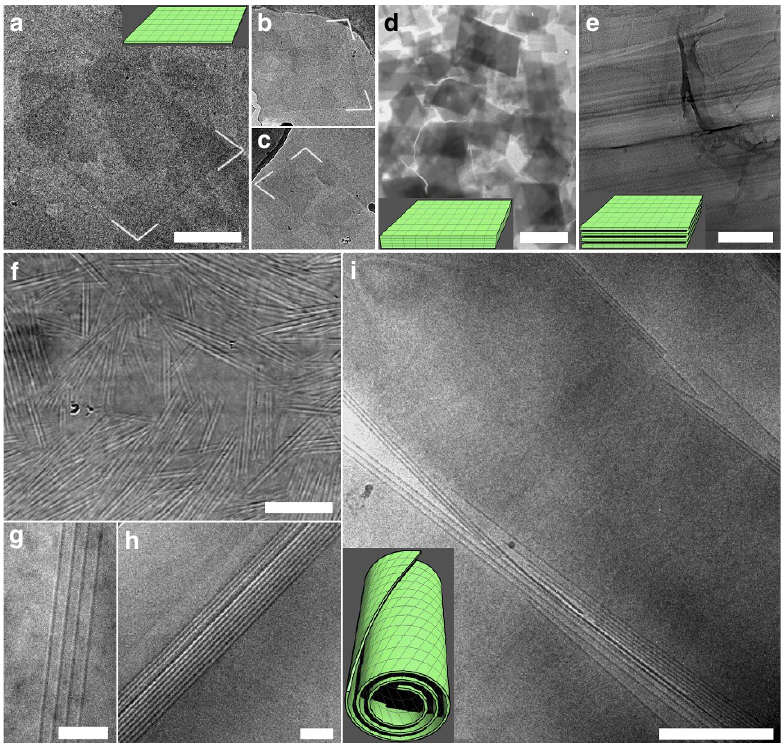
Figure 2 | Morphologies of the nanosheet-based and tubular structures formed by SDS@2beta-CD complexes. ( a – c ) Cryo-TEM pictures of parallelogram nanosheets with an obtuse angle of 104 (cid:2) , scale bar, 200nm. ( d ) A TEM image of flake crystals with a shape identical to that of the nanosheets, scale bar, 5 m m. ( e ) A freeze-fractured TEM picture of lamellar structures, scale bar, 100nm. ( f – i ) Pictures of multilamellar tubular structures: an overview ( f , optical microscopy, scale bar, 20 m m), zoom-in of the tube walls ( g and h , cryo-TEM, scale bar, 100nm), and a fractured tube ( i , cryo-TEM, scale bar,